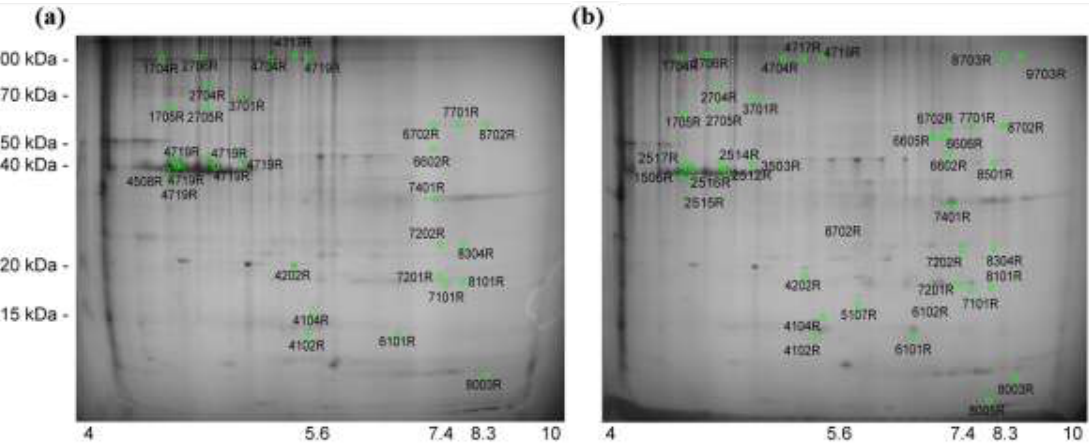
Figure 1. Representative 2-DE maps of proteins extracted from the PH 3 -S ( a ) and PH 3 -R ( b ) strains of Sitophilus oryzae . The spots were visualized by silver staining. Differentially accumulated protein spots are indicated by green sashes and numbers. The 2-DE was repeated at least three times for each group.